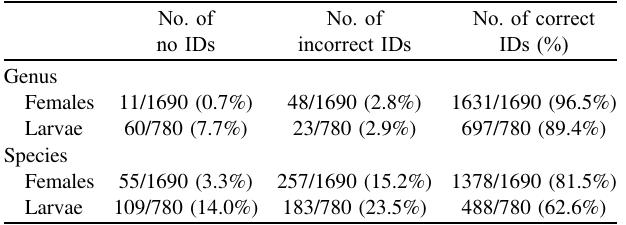
Table 1. Number of identi fi cations (No. of IDs) at genus and species level for mosquito females ( n = 26) and larvae ( n = 12) within the total of 65 usable